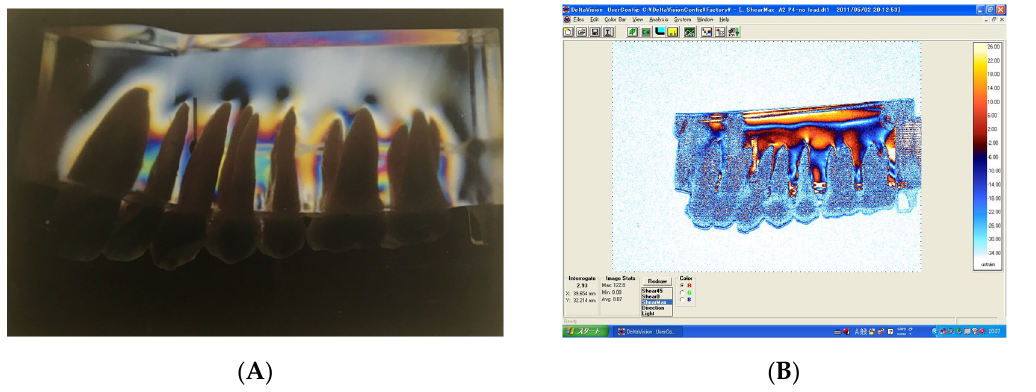
Figure 3. ( A ) Analog photoelastic model with the stress patterns appearing as fringes or bands of color. ( B ) Digital photoelastic analyzing image on a PC screen with stress distribution appearing by digital processing.